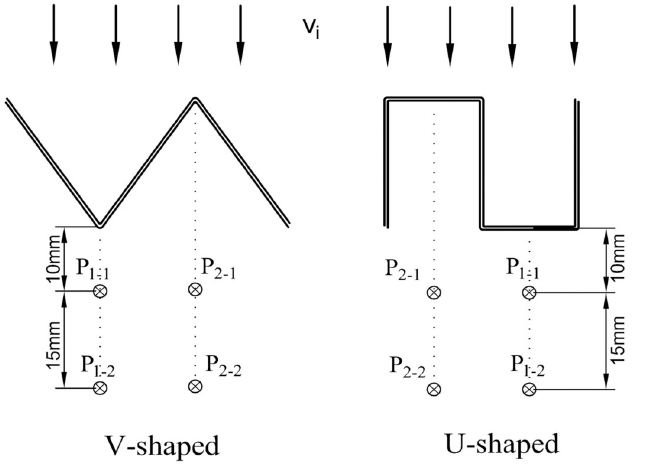
Fig 5. Positions of local air velocity measuring points.